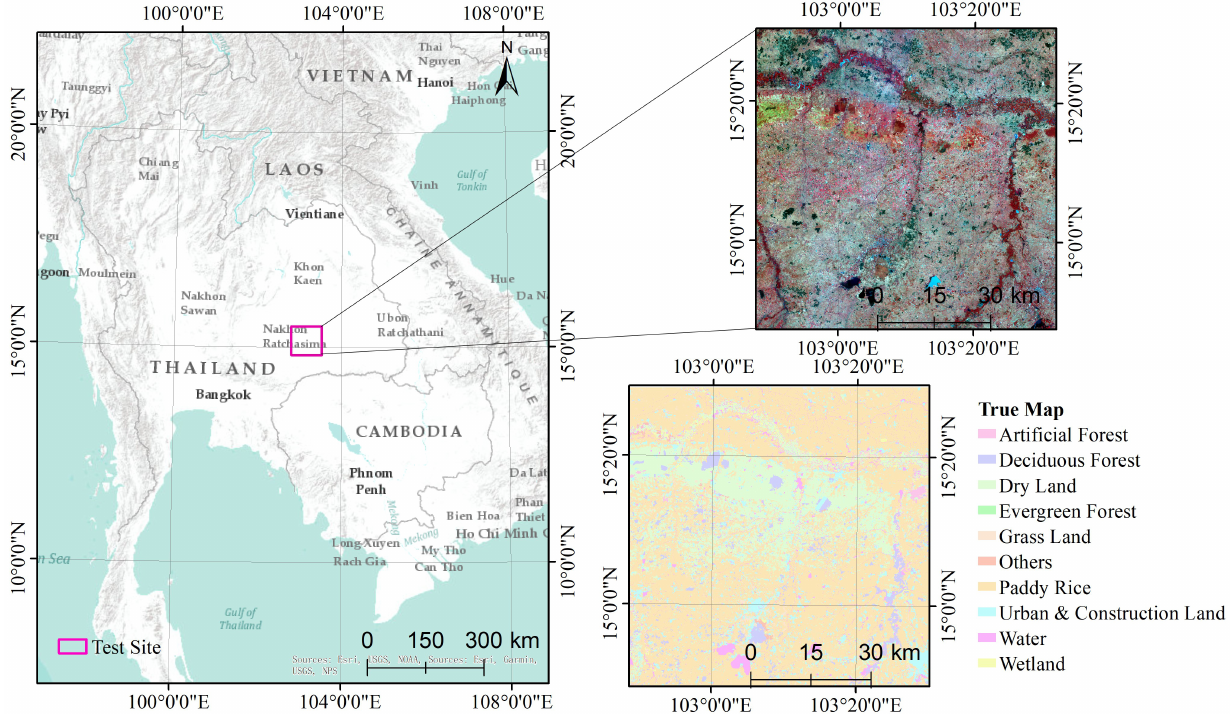
Figure 1. Location of the test